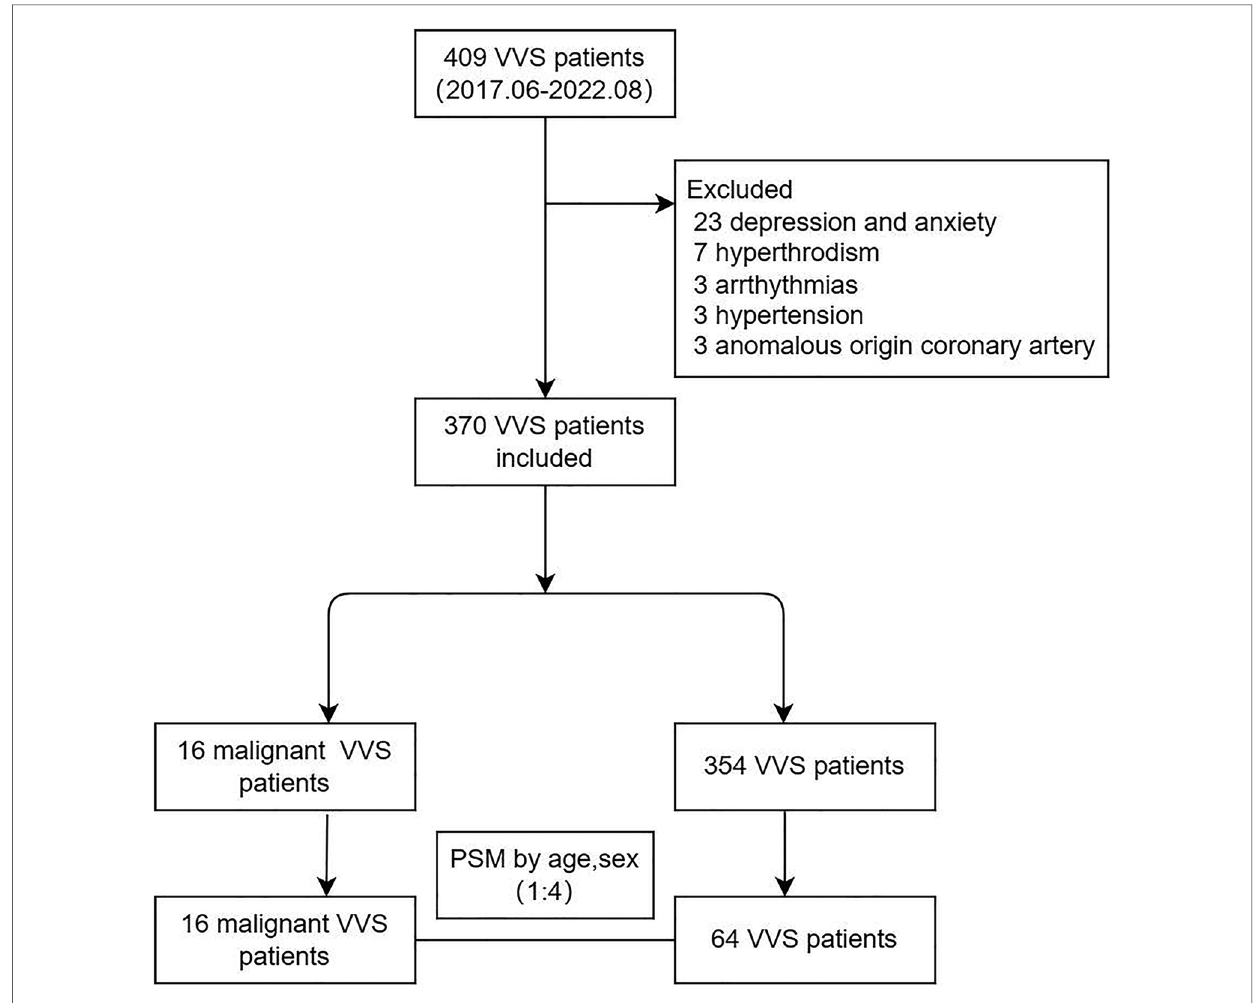
FIGURE 1 Flow chart of enrolled participants. Abbreviations: PSM, propensity score